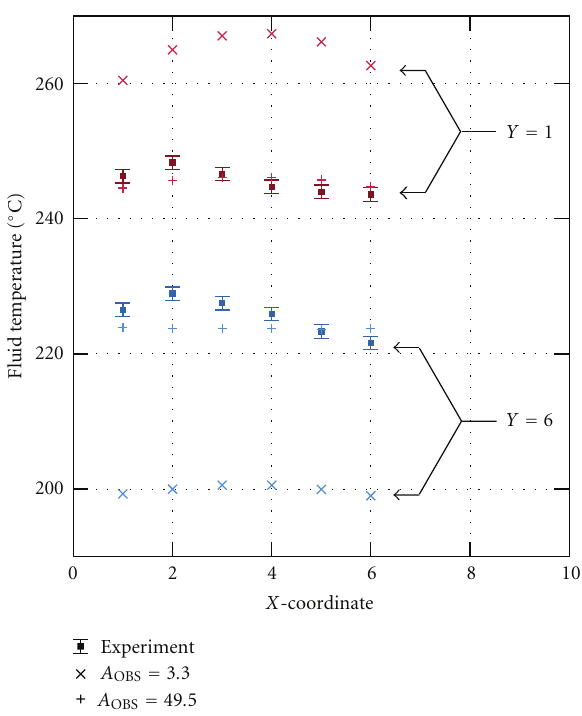
Figure 6: Outlet fluid temperatures along the hot side ( Y = 1) and cold side ( Y = 6) of the bundle for case